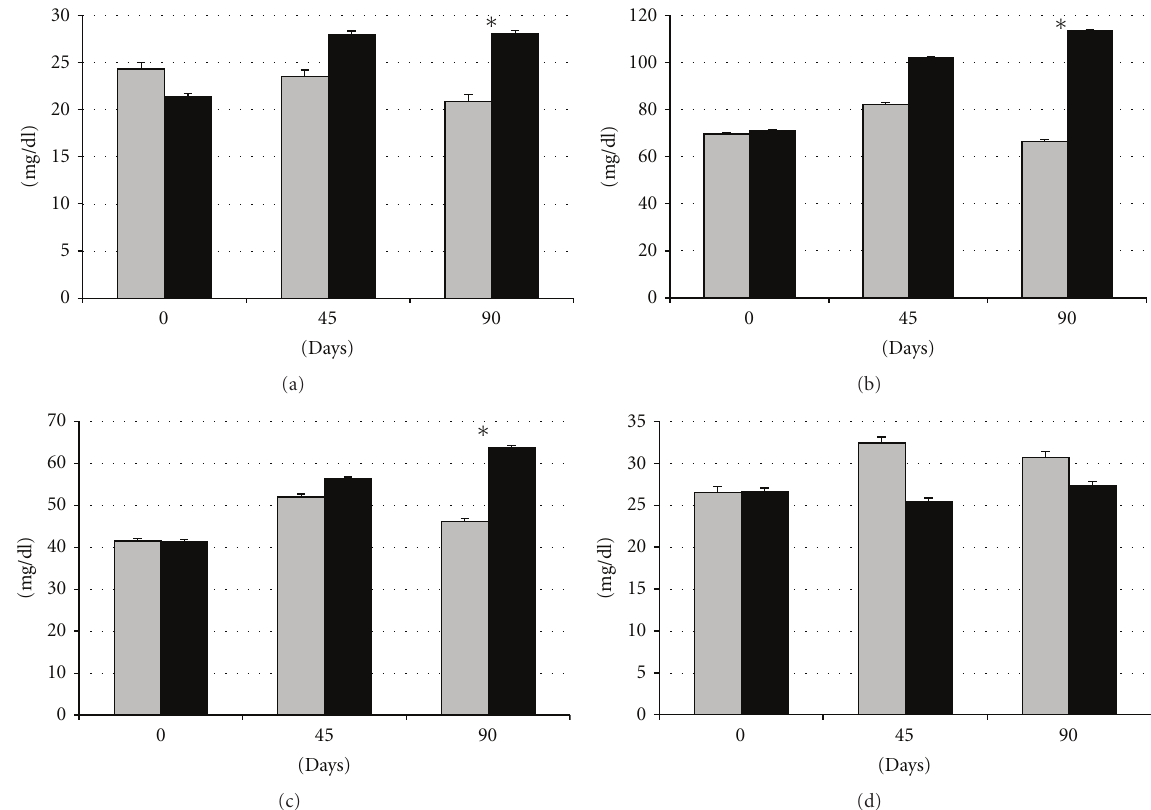
Figure 2: Changes in plasma concentration of triglycerides (a), cholesterol (b), LDL-c (c), and HDL-c (d) over time after di ff erential feeding in control sows (grey bars) and sows with ad libitum access to a diet enriched with saturated fat (black bars). Asterisks indicate significant di ff